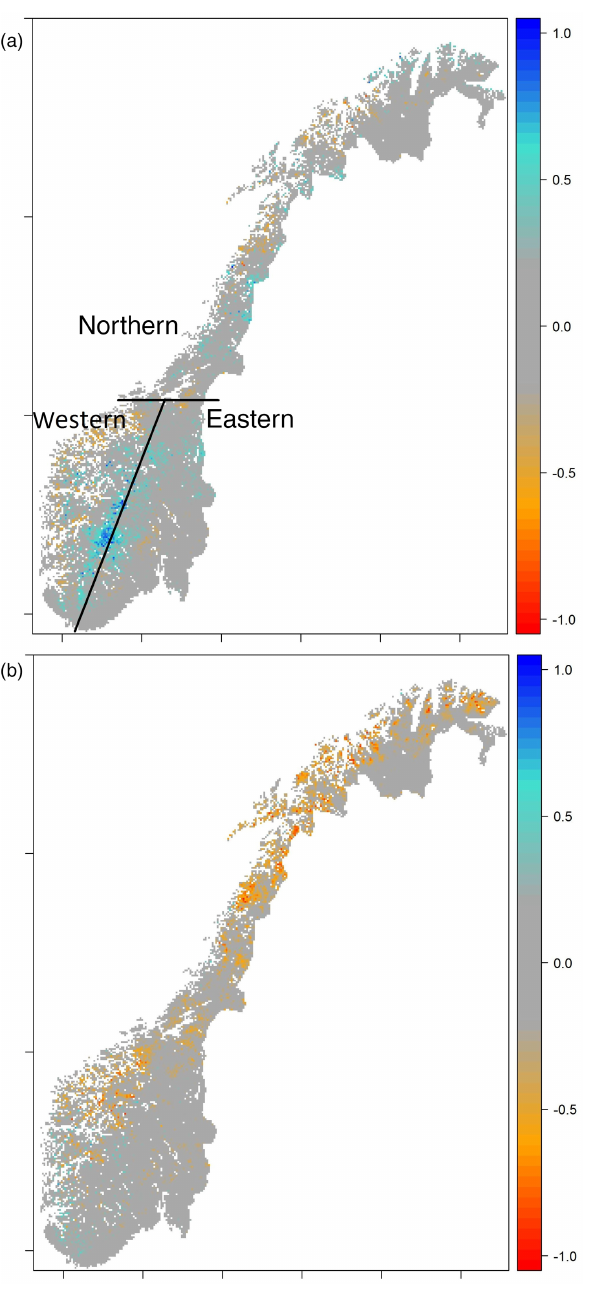
Figure 7. The bias index B for SCA in the seNorge grid cells for the two gridded dataset versions (v.1.1. in a and v.2 in b ) in March–July 2001–2015. In (a) , the three regions used in Fig. 6 are shown.